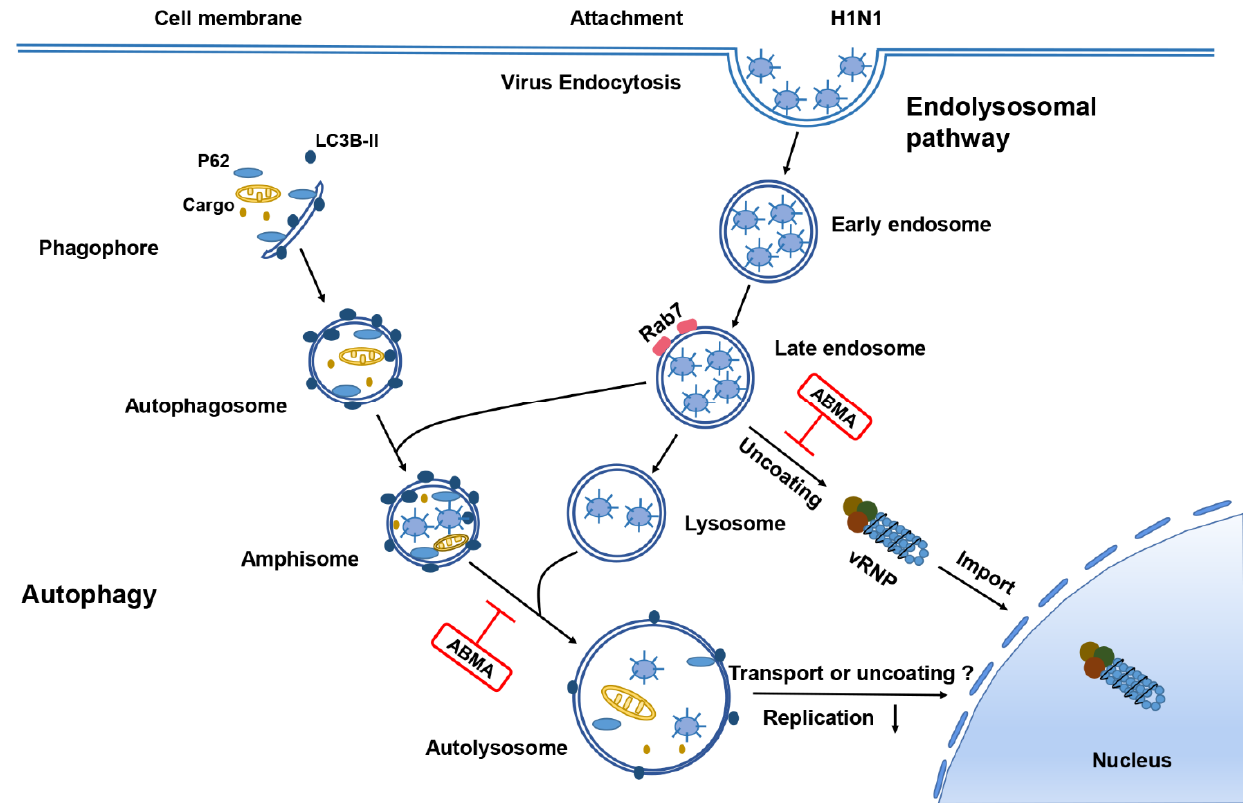
Figure 7. Model depicting the role of ABMA at the early stage of H1N1 infection via the regulation of the endolysosomal pathway and autophagy in mammalian cells.